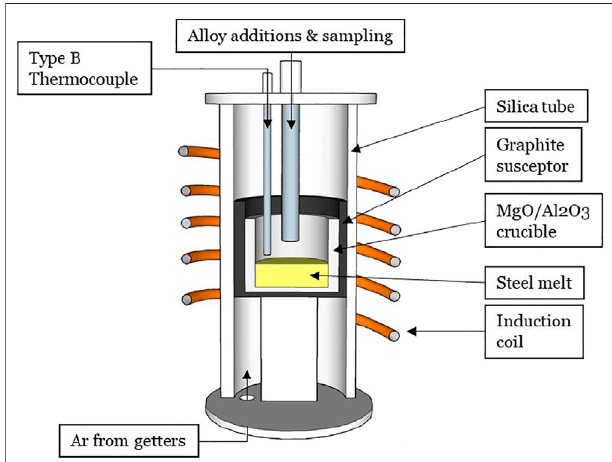
FIGURE 1 | Simpli fi ed diagram of the induction furnace used for experiments.